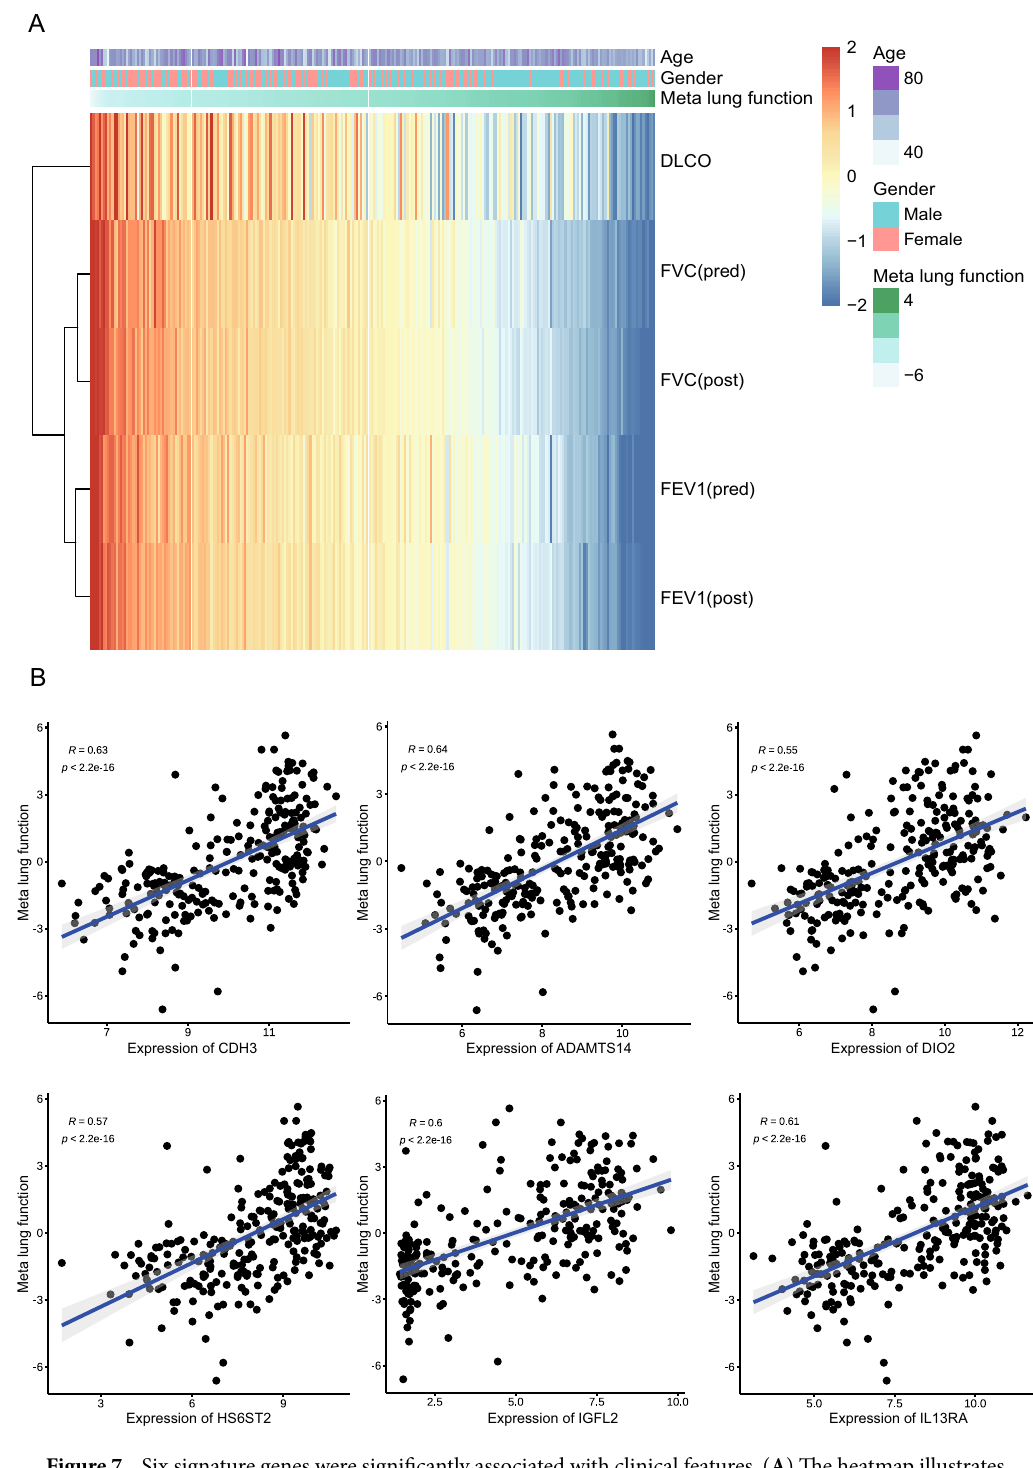
Figure 7. Six signature genes were significantly associated with clinical features. ( A ) The heatmap illustrates the computationally derived meta lung function variable combing multiple lung function parameters. In the upper part of the heatmap, the color in the meta lung function module gradually changes from white to green, representing an increase in the sample meta lung function; the blue bars in the gender module represent male samples, and the red bars represent female samples; the age module The color gradually changes from white to purple, representing the increasing age of the sample. On the right side of the heat map, there are clinical indicators DLCO, FVC (pred), FVC (post), FEV1(pred), and FEV1(post). Pred, predict; Post, post- bronchodilator. ( B ) The scatter plots show the positive correlation of the indicated genes with meta lung function. The x-axis represents gene expression, and the y-axis represents meta lung